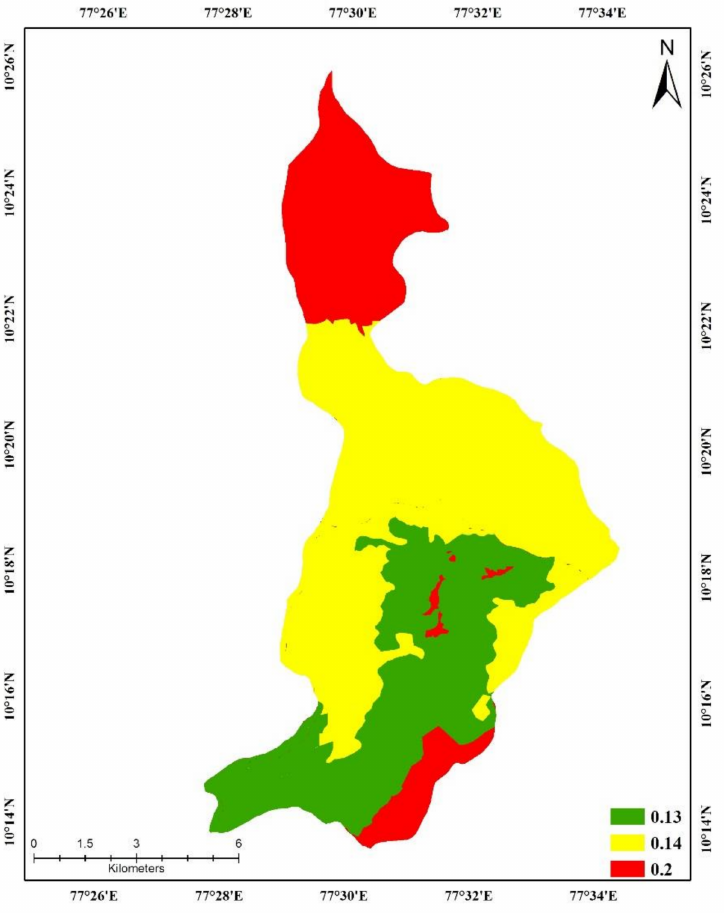
Figure 3. Spatial variation of soil erodibility (K)